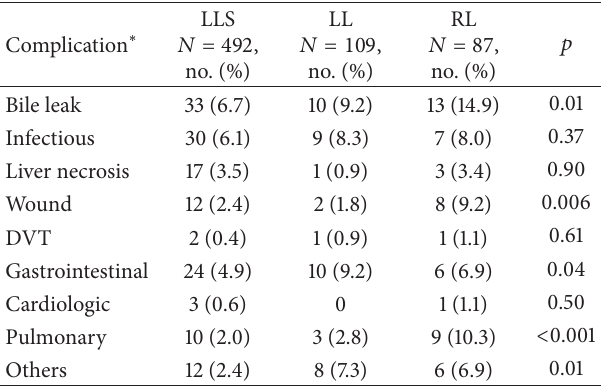
Table 3: Complication occurrence according to the type of liver resection.